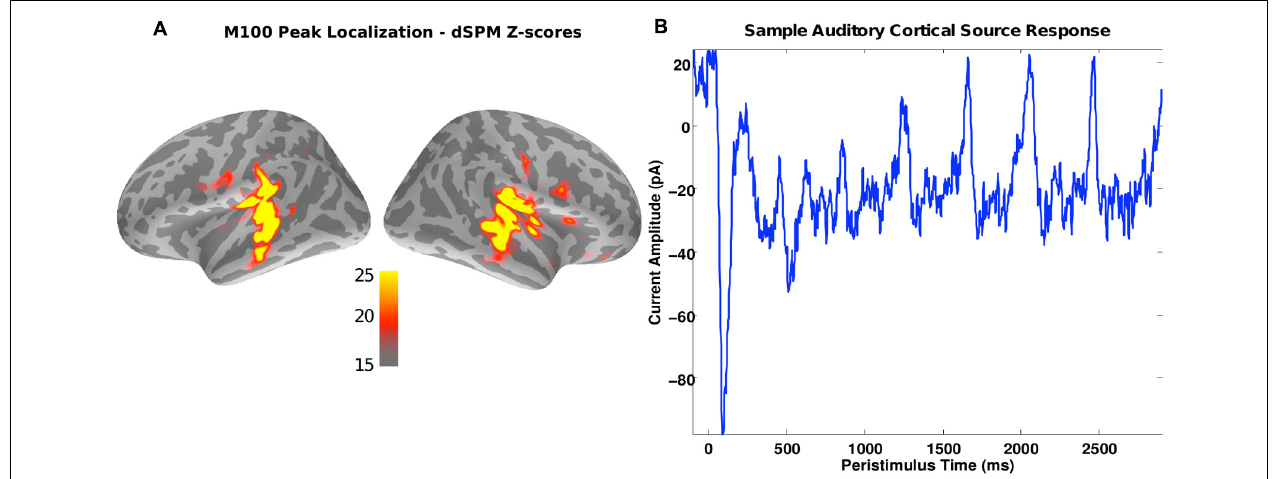
FIGURE 2 | (A) A source image estimate of the M100 peak in response to the sound onset for a representative subject. Colors indicate the z -scores obtained using the dSPM method. As expected, the primary auditory cortices show up as “hot” spots in the image.The regions exceeding a z -score